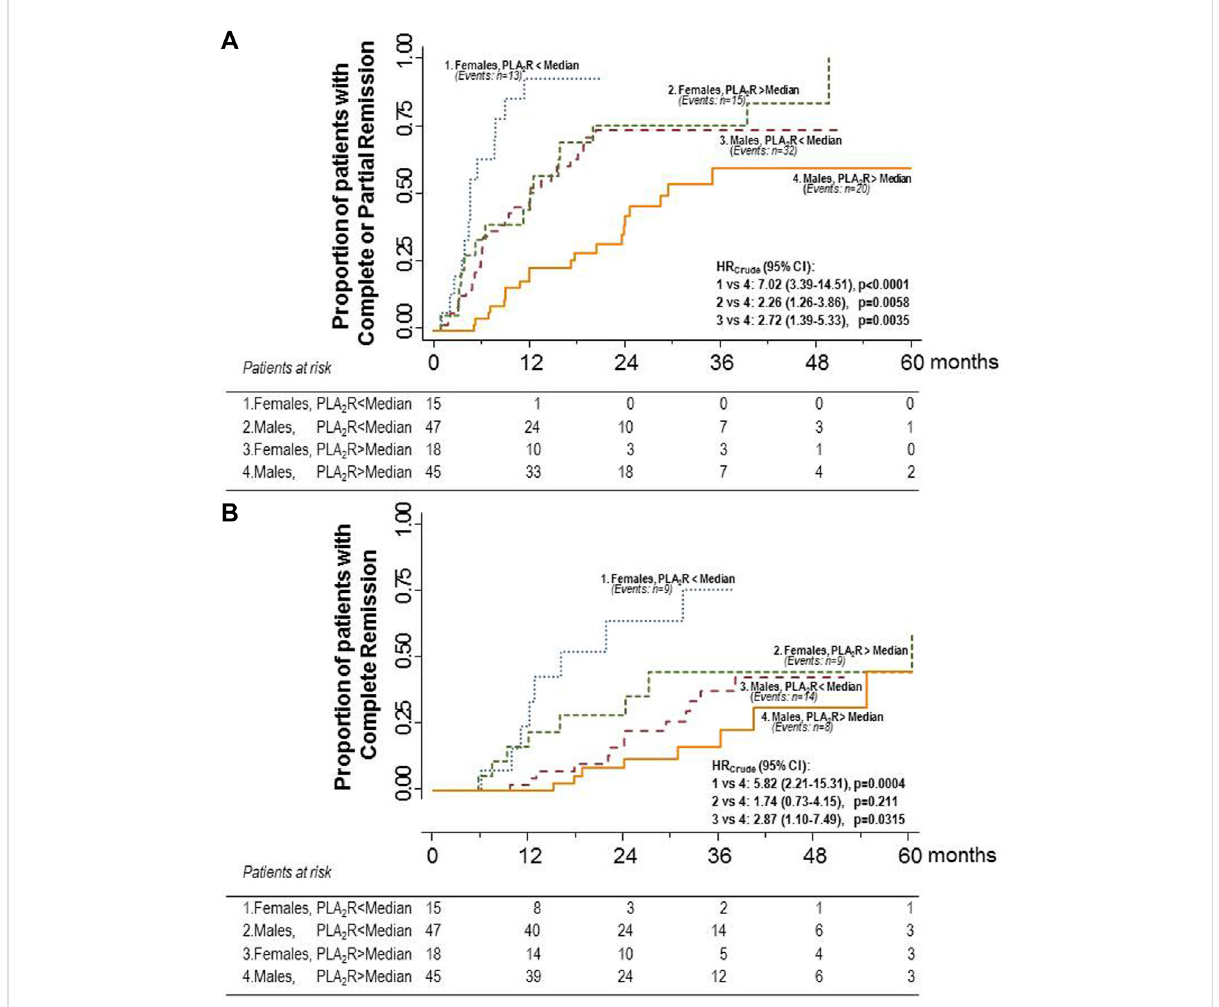
FIGURE 3 Kaplan – Meier curves for the proportion of participants with primary MN who progressed to the combined endpoint of complete or partial remission (A) ortocompleteremissionconsideredasasingleendpoint (B) inthefoursubgroupsofmaleorfemalepatientswithanti-PLA 2 Rantibody titer above or below the median considered separately. The highest probability of progressing to the combined endpoint was observed in females with anti-PLA 2 R antibody titerbelow themedian. A slightly lower probability of progressing to thecombined endpoint wasobservedin females with anti-PLA 2 R antibody titer above the median, whereas the probability crumbled in males with antibody titer below the median. The lowest probability was observed in males with antibody titer above the median. Differences between considered subgroups versus the subgroup of males with antibody titer below themedian (reference group) were signi fi cant. A similar trend was observed for completeremission, considered as asingle